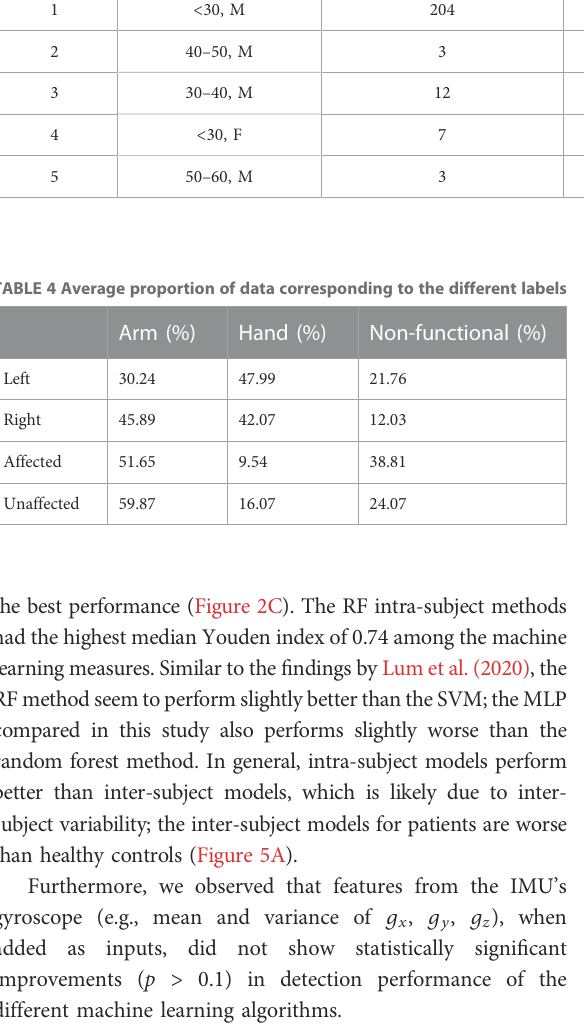
TABLE 3 Demographic details of patients CVA — Cerebrovascular accident; TBI — Traumatic Brain Injury. Sl. No.